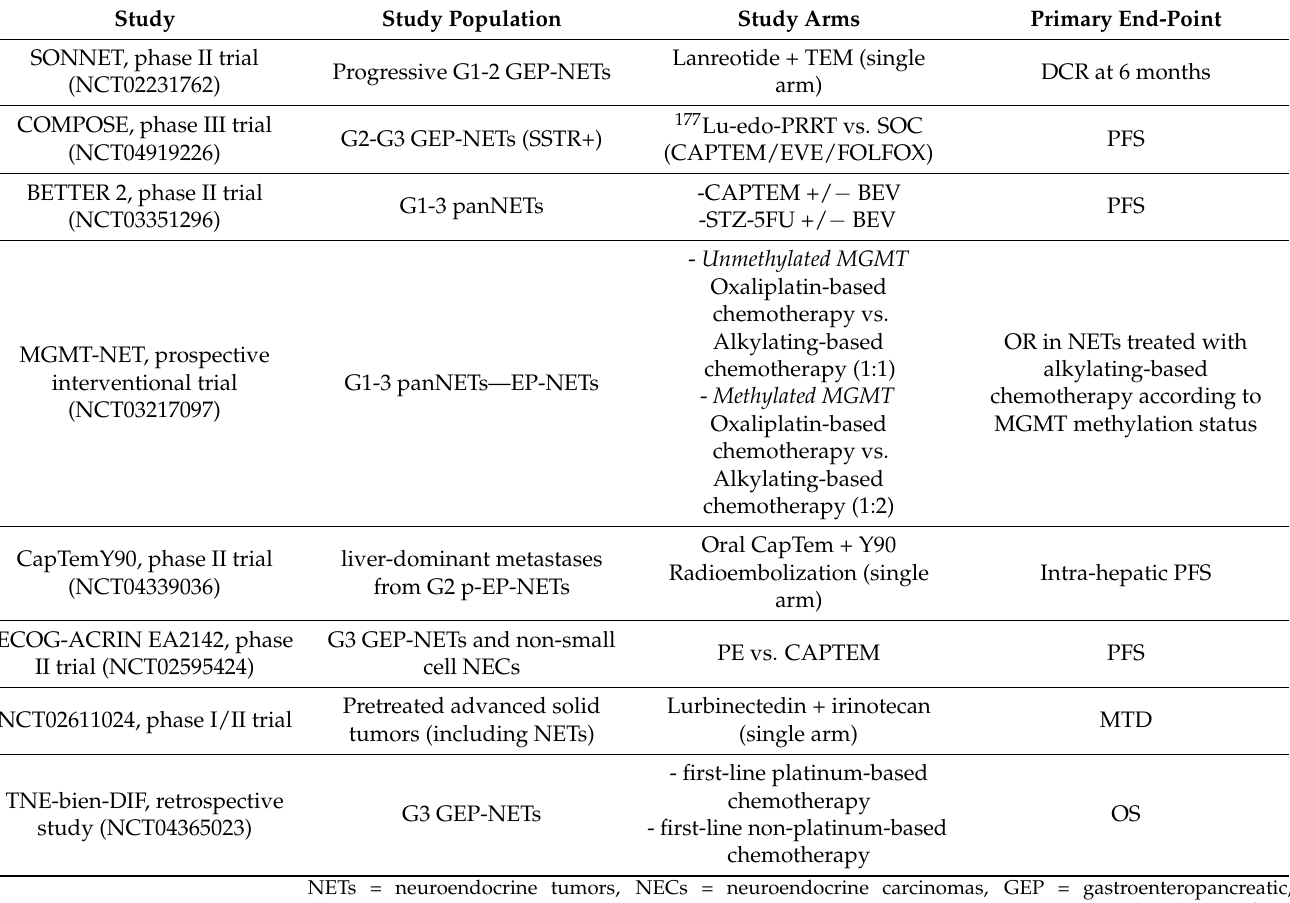
Table 4. Ongoing studies on chemotherapy use in well-differentiated neuroendocrine